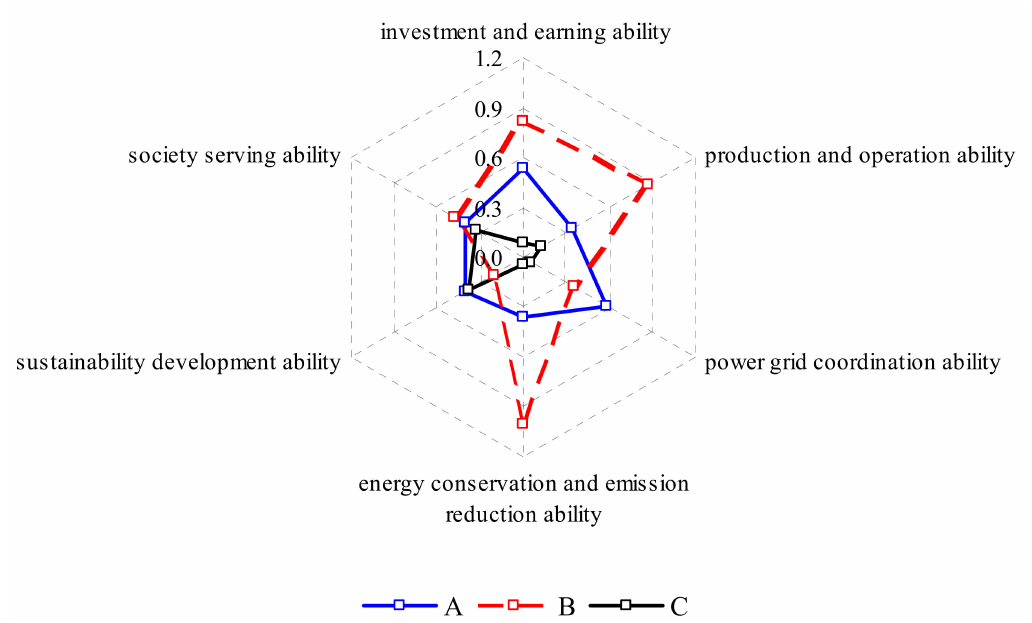
Figure 6. Core abilities evaluation results of each distributed PV